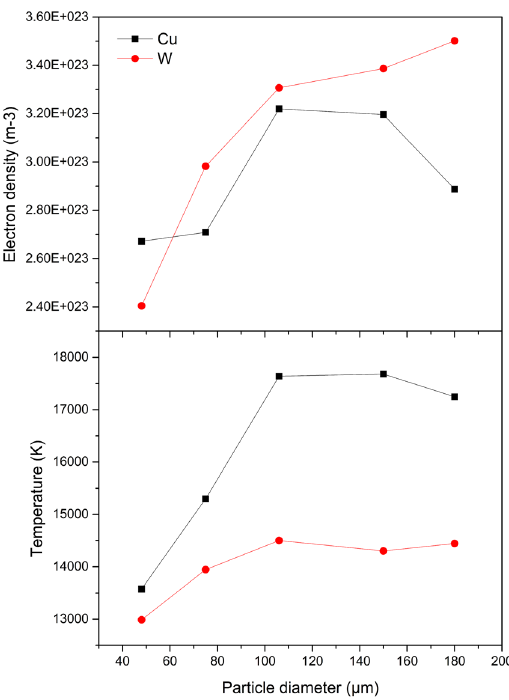
Figure 5. Variation of plasma parameters with particle diameter: ( a ) electron density; ( b )